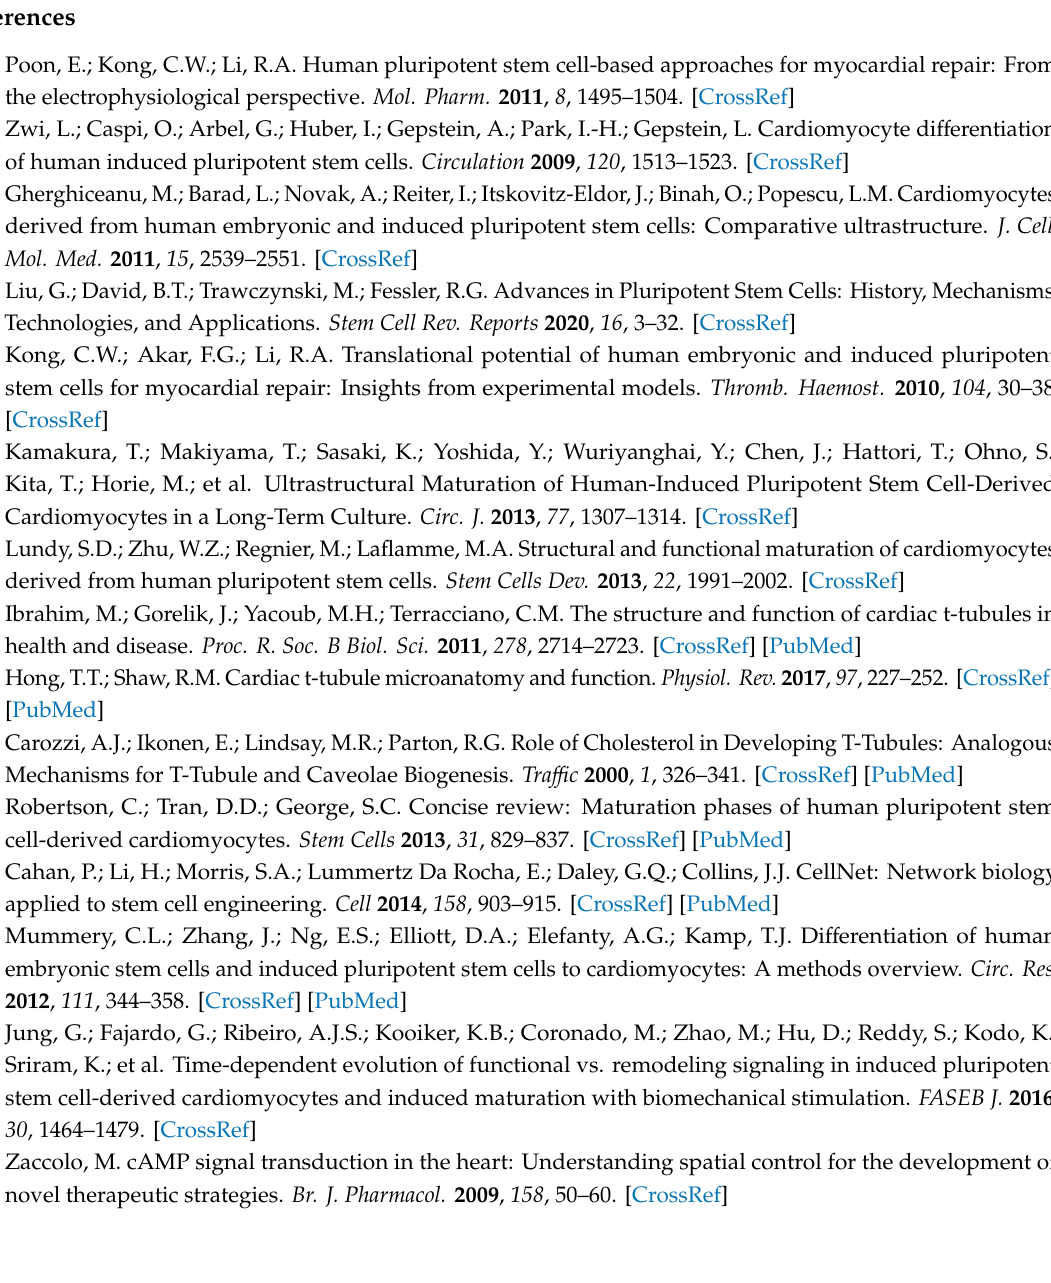
Figure S1: Cyclic AMP levels in iCell cell line following cholesterol removal and selective β 1 AR or β 2 AR stimulation. Table S1. Sequences of primers used in the